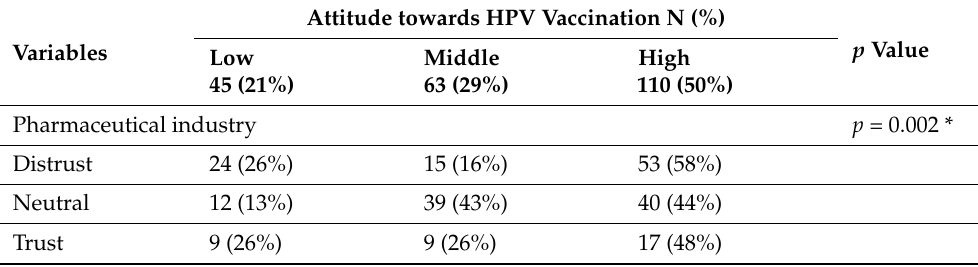
Table 3. Association between attitude towards HPV vaccination and the trust to the sources, N = 218.